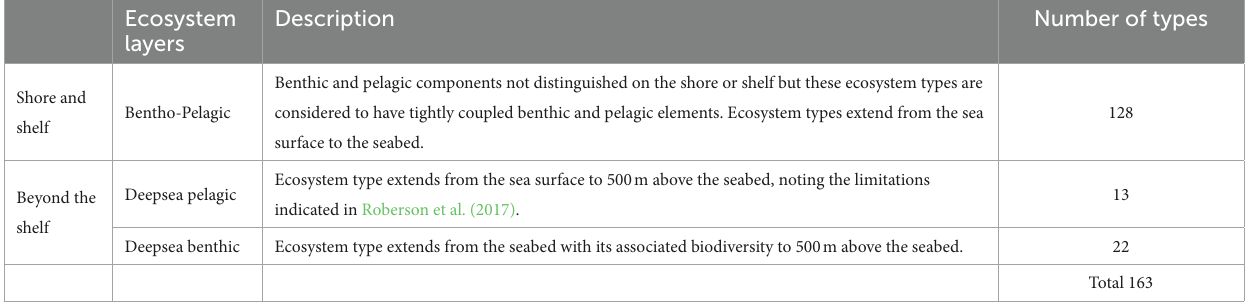
TABLE 1 Description of vertical stratification in South Africa’s 2022 marine ecosystem